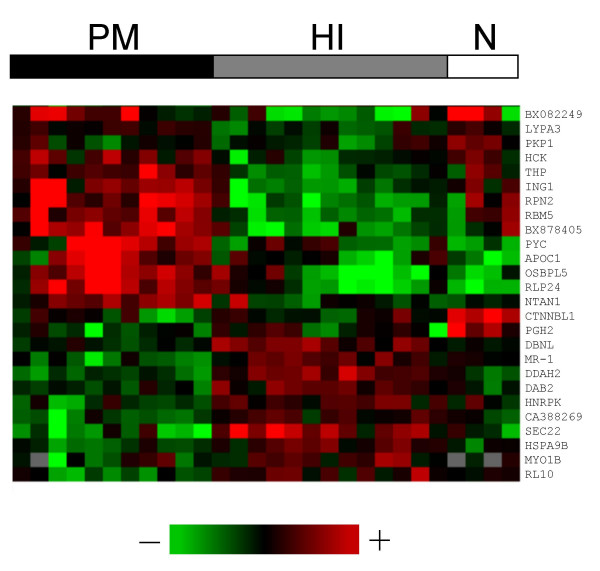
Unsupervised average linkage clustering analysis of the 26 differentially abundant genes in eggs collected after photoperiod-manipulated ovulation (PM), hormonally-induced ovulation (HI) and natural ovulation (N). Each row represents a gene and each column represents an egg RNA sample. For each gene, the expression level within the sample set is indicated using a color intensity scale. Red and green are used for over and under abundance respectively while black is used for median abundance.